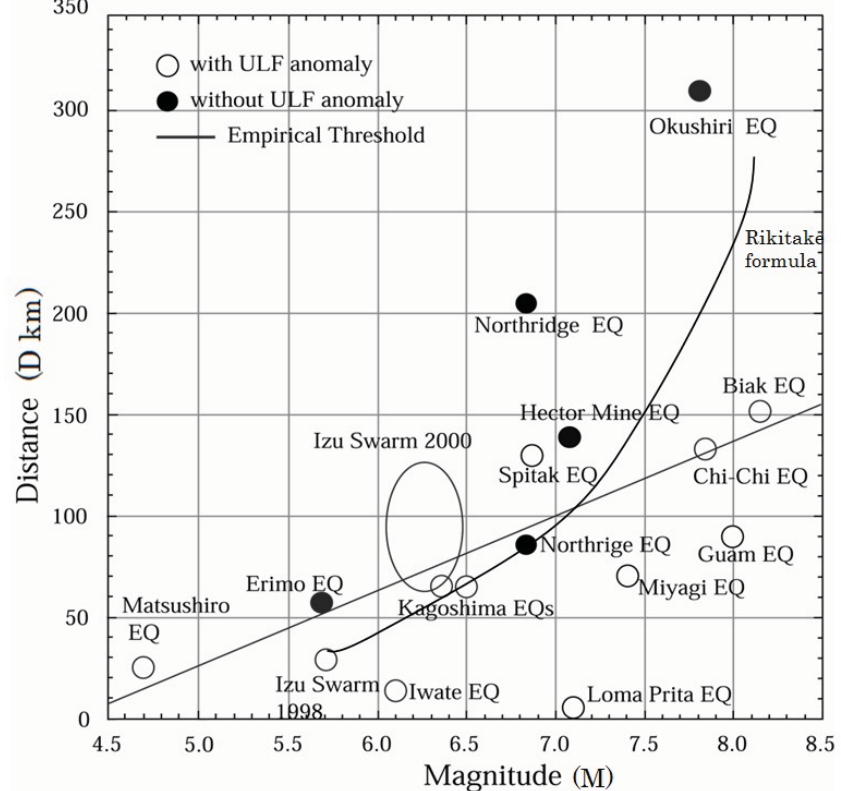
Figure 4. Summary of seismogenic ultra-low-frequency (ULF) radio emissions as M-D plot. Open circles indicate events with ULF anomaly, solid circles event without ULF anomaly. Straight line: empirical threshold (0.025 D = M (cid:4) 4.5) by linear regression. Curve: Rikitake’s formula for unusual animal